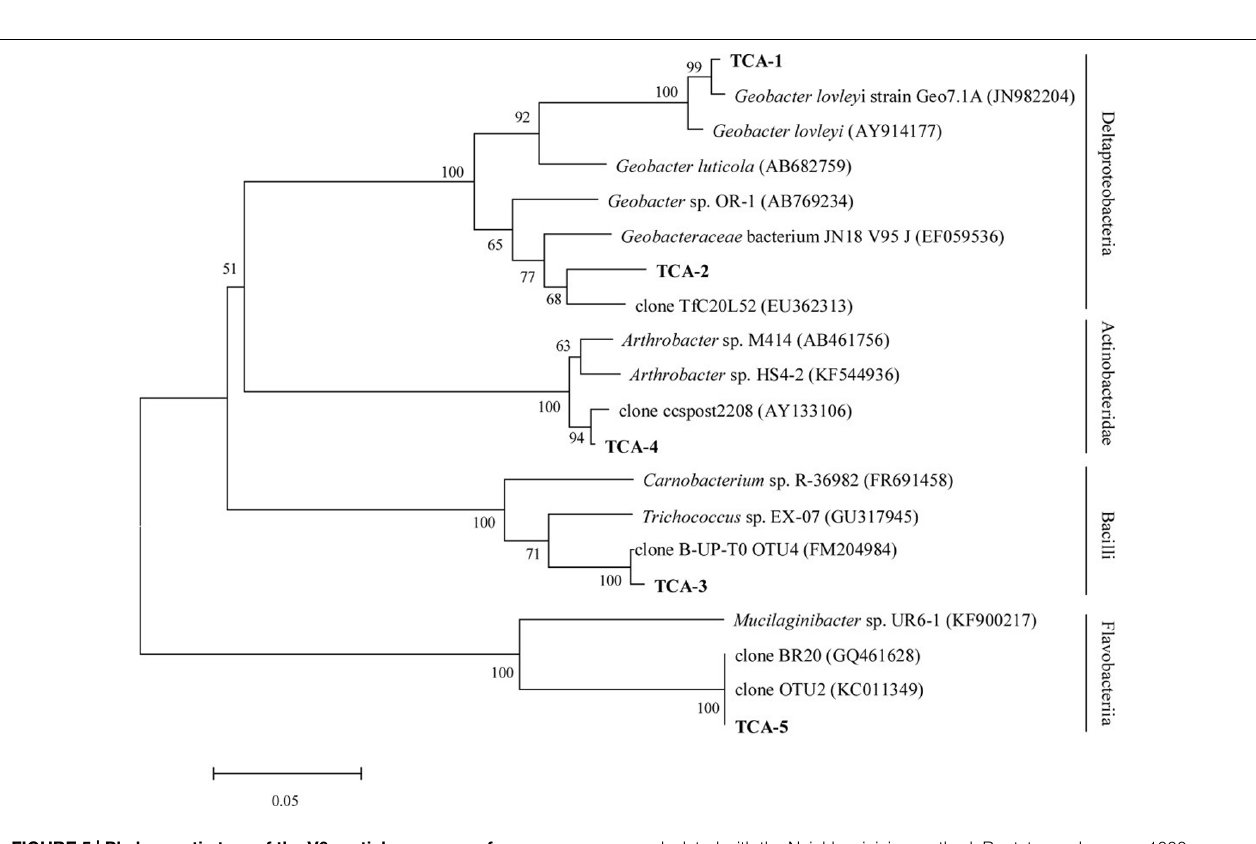
calculated with the Neighbor-joining method. Bootstrap values n = 1000 replicates. Of (cid:21) 50% were reported near the corresponding nodes. The scale bar represented 0.05 nuclear acid substitutions per nucleotide